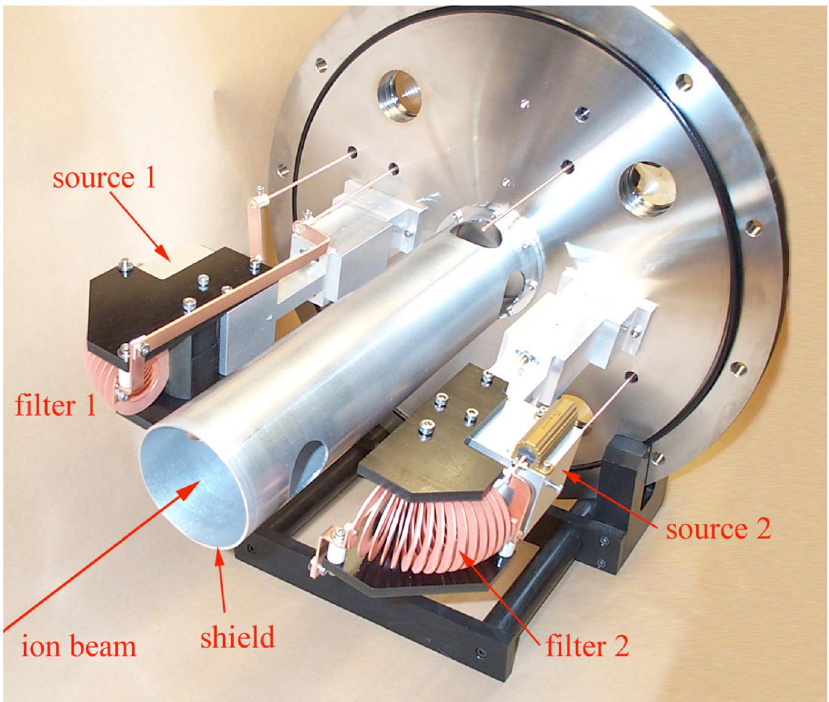
FIG. 24. (Color) NTX cathode-arc plasma sources mounted on a beam pipe. Plasma is injected in the path of the ion beam through openings in the aluminum metal shield. The shield is designed to reduce the magnetic field at the location of the ion beam, to limit plasma entering the quadrupole region, and to prevent macroparticles from the source from entering the beam region.